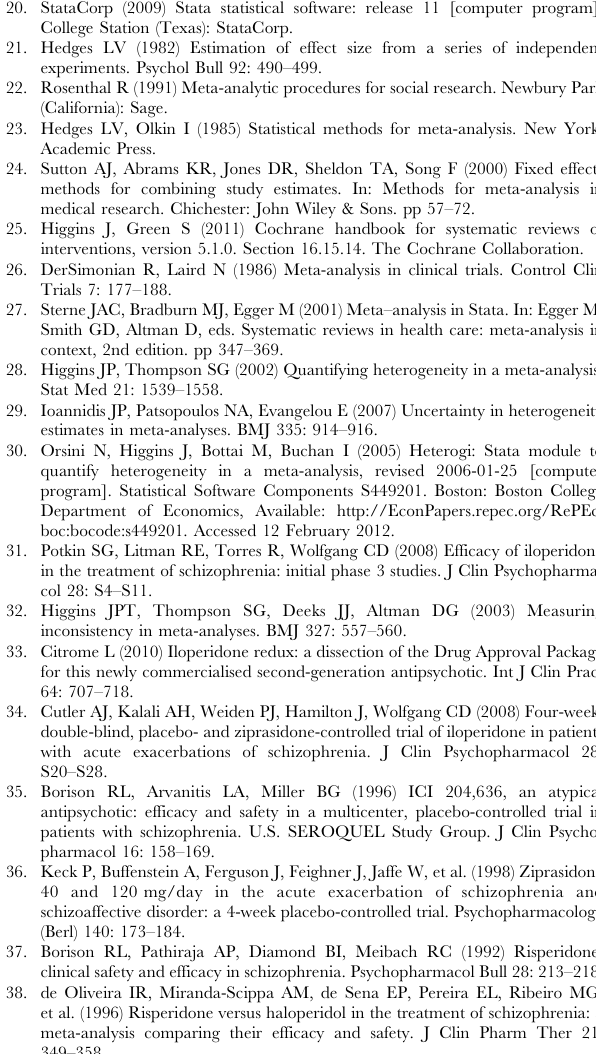
Table S3 Meta-analysis of clinical trial data from the published literature. Output from statistical program